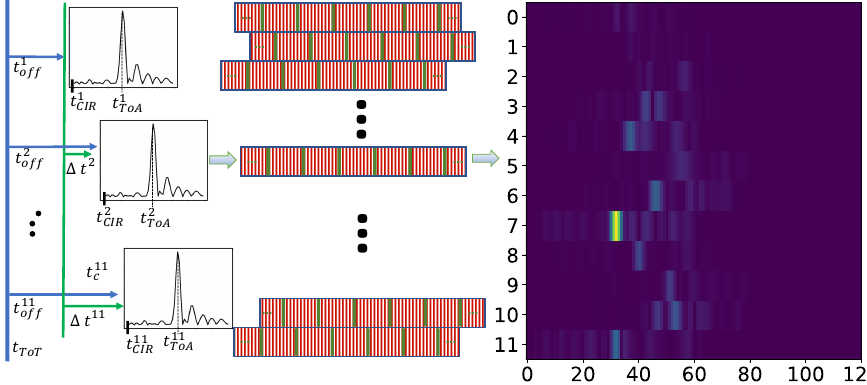
Figure 4. Data pre-processing: CIR calibration and